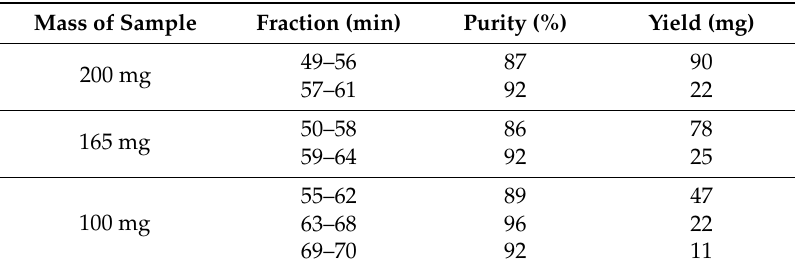
Table 3. The influence of sample mass on the purity and yield of β -elemene.